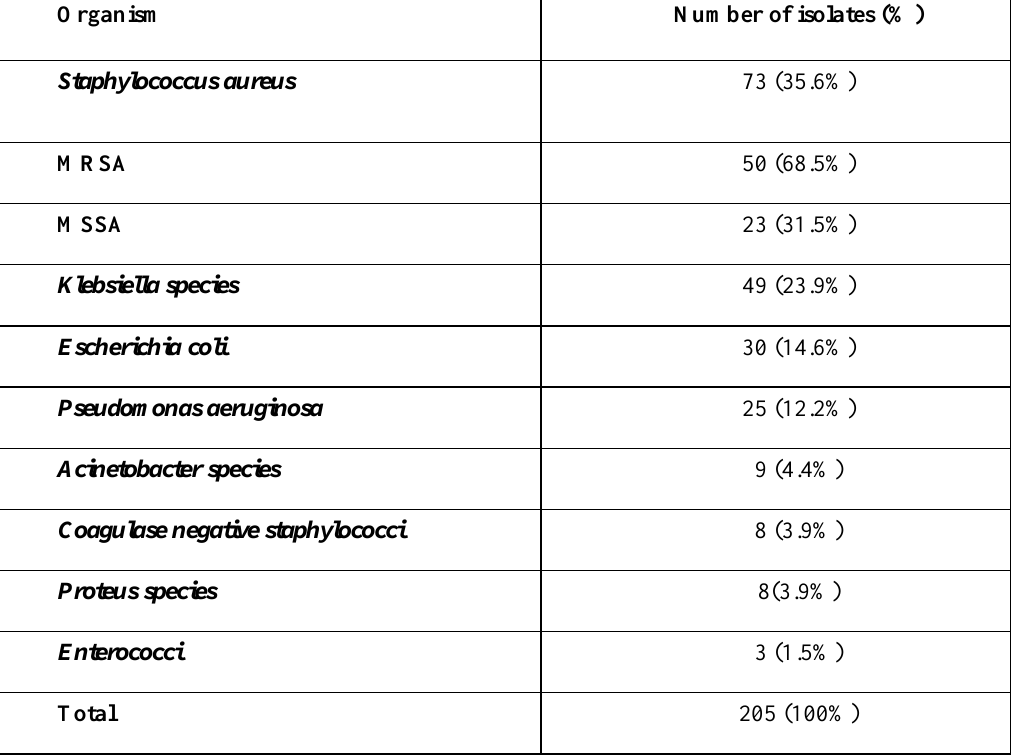
Table 2. Characterization of bacterial isolates obtained from patients with surgical site infections.